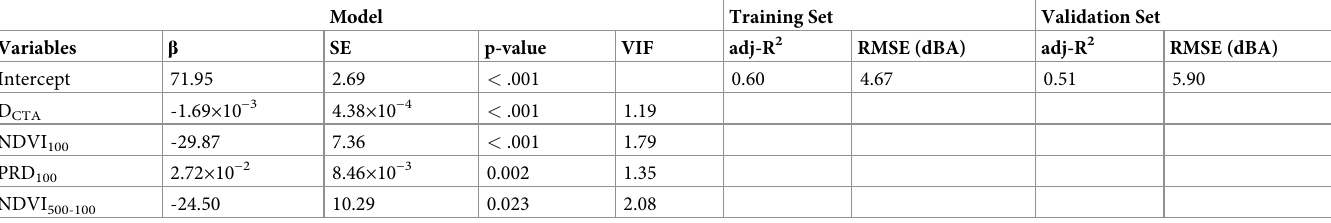
Table 2. Fitted land use regression model predicting daytime noise (L eq-5min , dBA) in Chicago, IL.